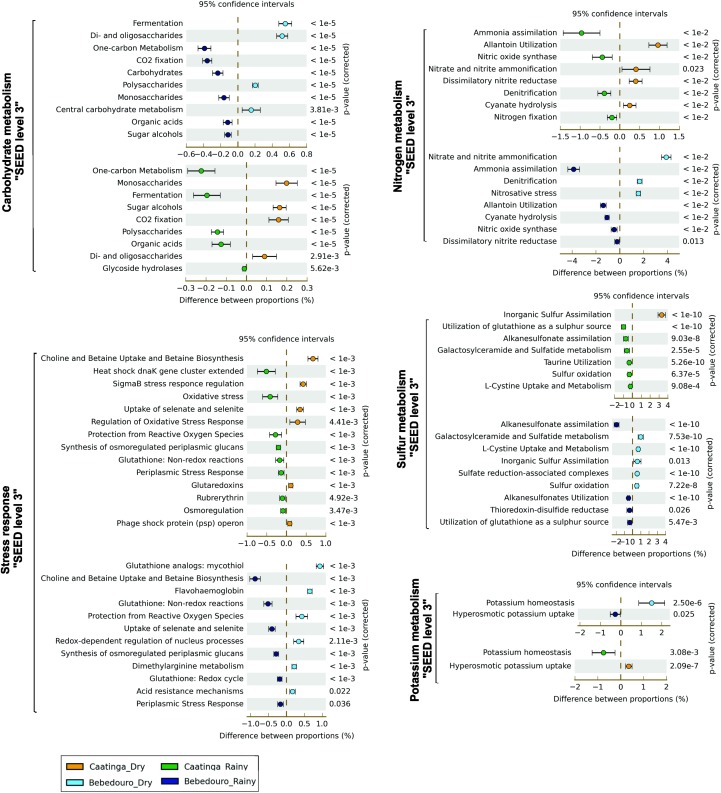
Fisher’s exact test-based comparative analysis of selected metabolic pathways of SEED subsystems (levels 2 and 3) enriched in dry and rainy seasons of CEF and BEF. The Story’s FDR correction was used at P < 0.05 filter.